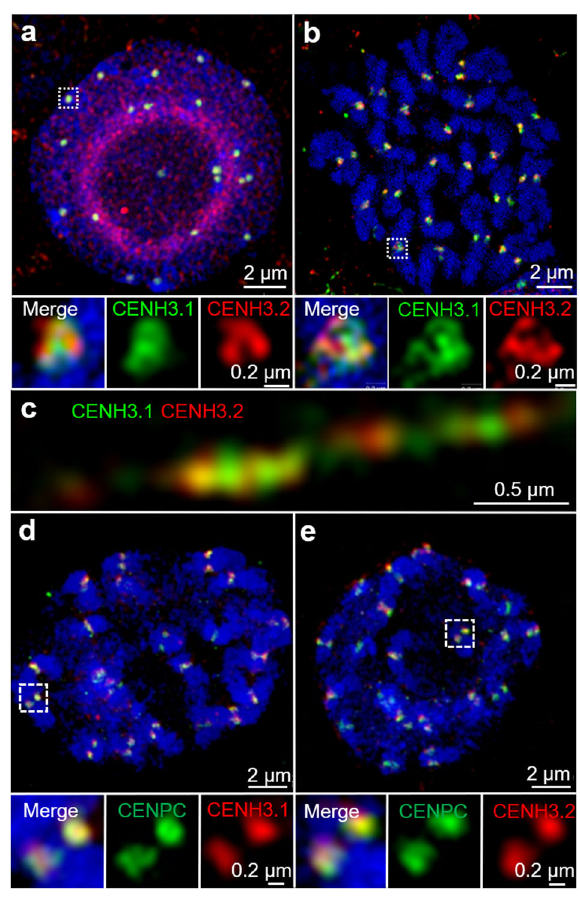
Fig. 3 The organization of cowpea centromere analyzed by indirect immunostaining and structured illumination microscopy (SIM) in root cells. a Both CENH3.1 (green) and CENH3.2 (red) occupy distinct domains at centromeres in interphase nuclei. b Prometaphase chromosomes. Partially overlapping CENH3.1 and CENH3.2 immunosignals of further enlarged centromere regions of ( a ) and ( b ) and of the extended chromatin fi ber ( c ) suggest that centromeric nucleosome cluster contain either CENH3 variant. d , e CENH3.1 (red) and CENH3.2 (red) colocalizes with CENPC (green) at the centromeres of prometaphase chromosomes. Further enlarged centromere regions shown below are indicated with white boxes ( a , b , d , e